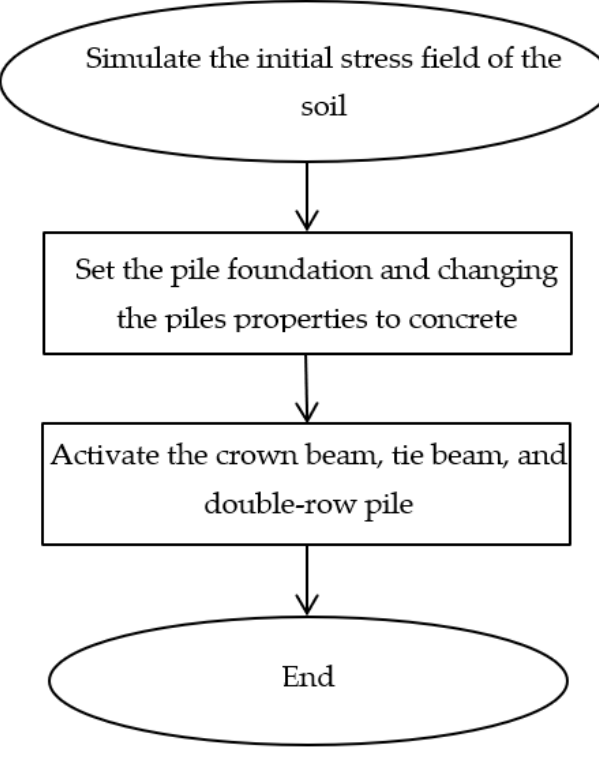
Figure 5. Construction stages flowchart.